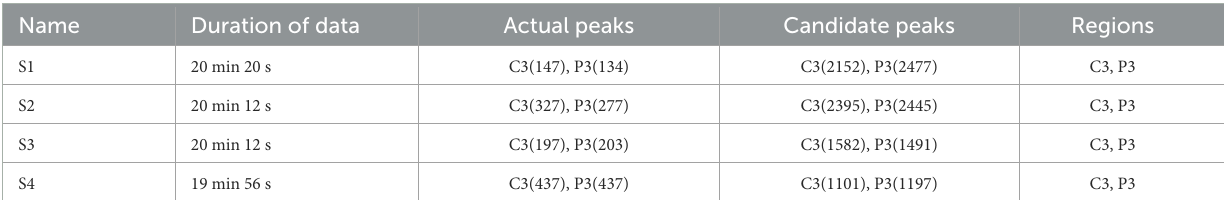
TABLE 2 Comparison of raw data of spikes (actual peaks) and candidate spikes obtained by specific template matching (candidate